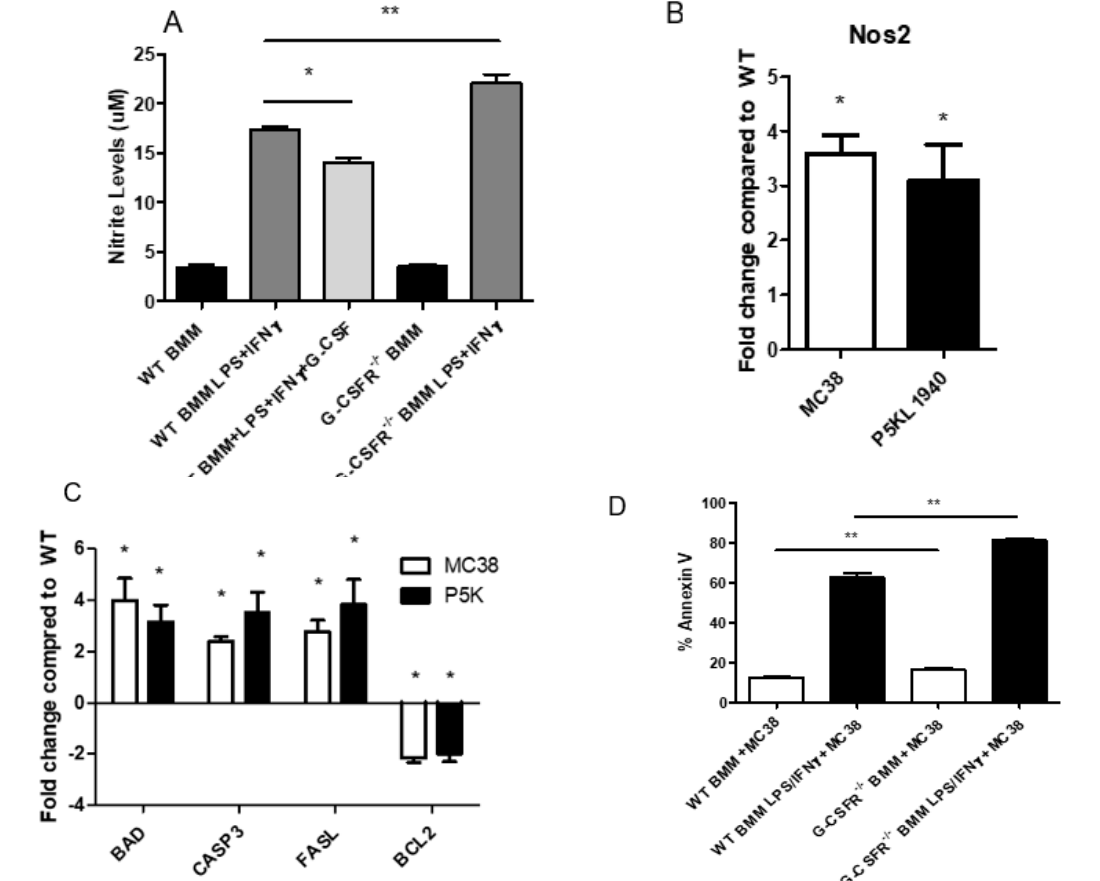
Figure 6. G-CSFR knockdown in macrophages promotes ( A ) increased nitrite levels by fluorometric plate assay, and in adoptive transfer models, ( B ) an increased NOS2 gene expression, and ( C ) increased gene expression of BAD , CASP3 , and FASL apoptosis genes with simultaneous decreased BCL2 proliferation gene. ( D ) MC38 incubation with LPS- and IFN γ -treated macrophages also shows increased tumor killing by G-CSFR − / − macrophages compared to WT by Annexin V staining for flow cytometry. n = 6 for ( A ), 10 for ( B ) and ( C ), and 6 for ( D ). * p and ** p ≤ 0.05.